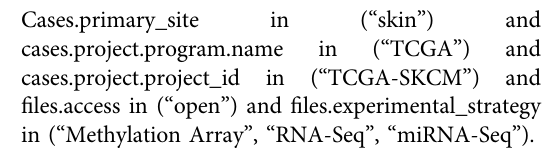
Frontiers in Molecular Biosciences |